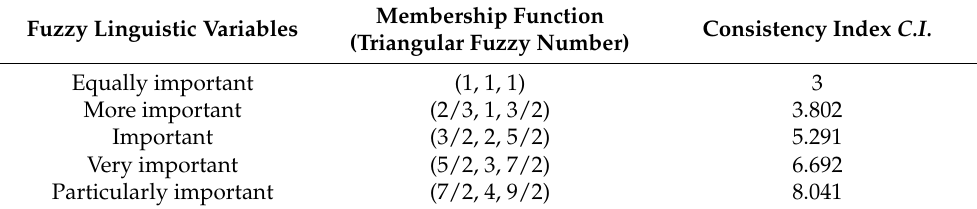
Table 4. Importance grade and consistency index C.I.